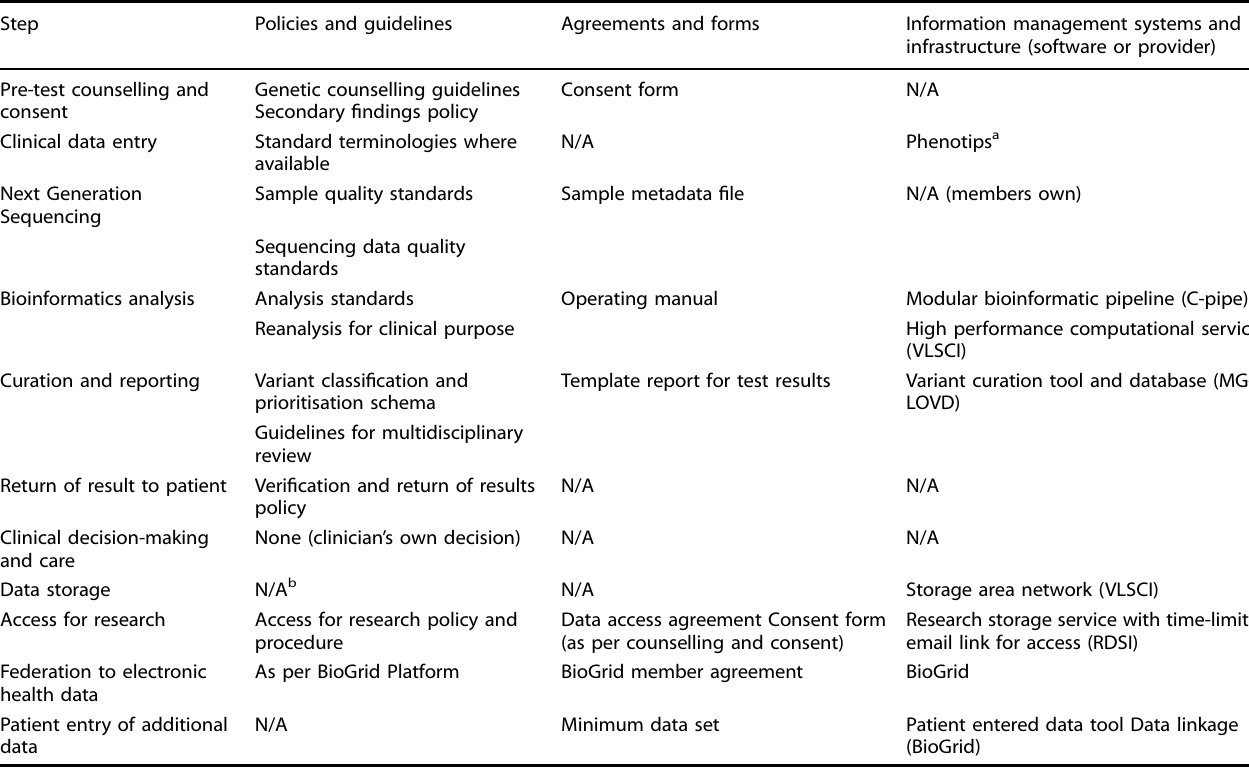
Table 1. The demonstration project's ‘ proof of concept model